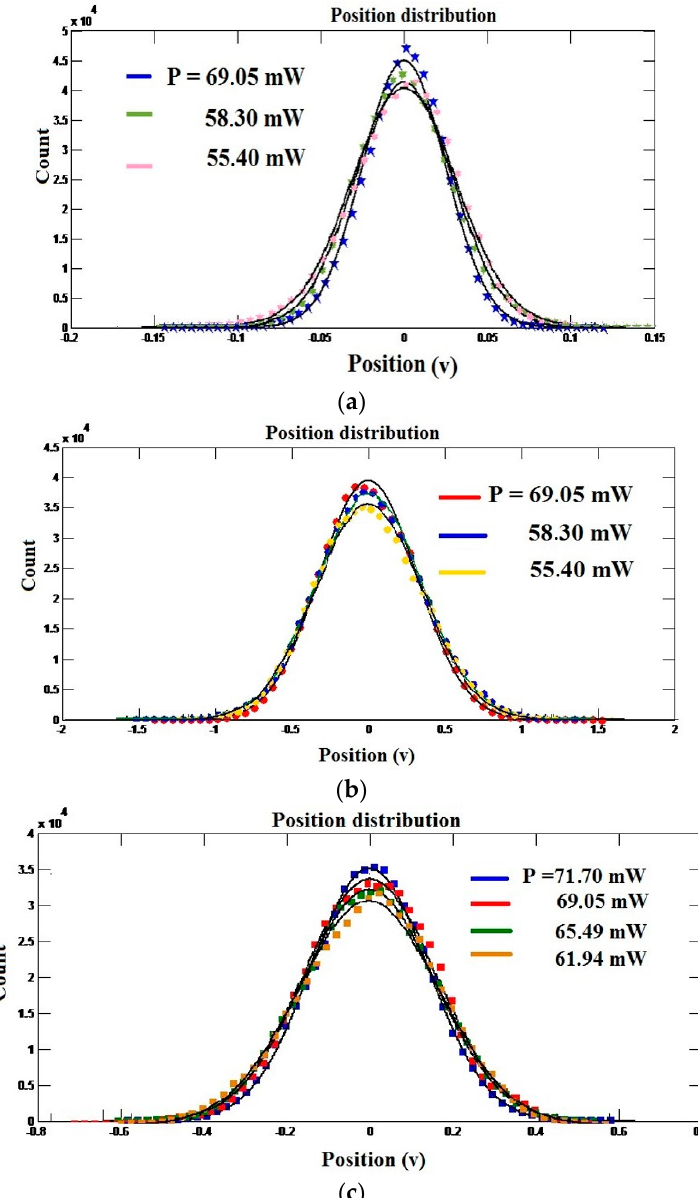
Figure 7. Statistical distributions for ( a ) microbead of 2 µm diameter, ( b ) two different microbeads stuck (2 µm–4.5 µm), and ( c ) pair microbeads of 2 µm diameter (2 µm–2 µm).